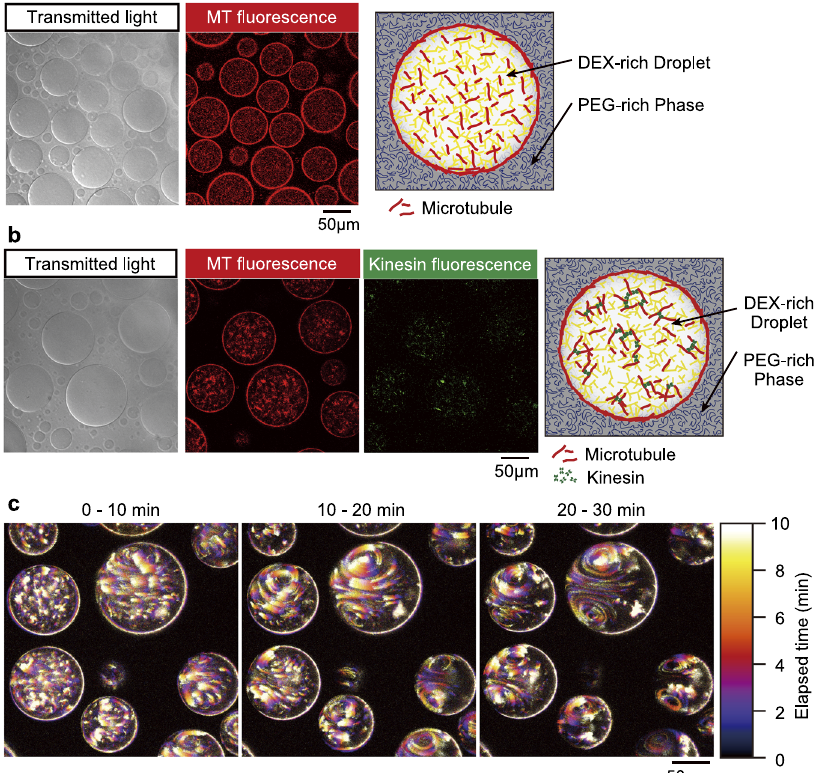
Fig. 1 Spontaneous formation of vortex fl ow inside a w/wPS droplet, entrapping MTs and kinesins through self-construction from a PEG/DEX aqueous solution. a Droplet generated from a PEG/DEX solution containing MTs. Mechanical mixing of a PEG/DEX binary solution close to the critical point and MTs spontaneously generates cell-sized DEX-rich droplets. MTs are distributed in the droplet and clearly visualized in fl uorescent images. They are localized at the interface to make an arti fi cial cortex. b Droplet generated with MTs and kinesins in the absence of ATP. Addition of kinesin tends to cross- link MTs. The accumulation of kinesin in the aggregates was con fi rmed by the fl uorescent images. The cortical structure was preserved with the addition of kinesin. c The generated fl ow is driven by the chemical energy dissipation of ATP. Time development of the vortex fl ow inside of droplets. The snapshots are superimposed images for 10 min, where the fl ow was visualized based on the presence of MTs. Pseudo colour represents the elapsed time. A clear pair of vortices appear 20 min after